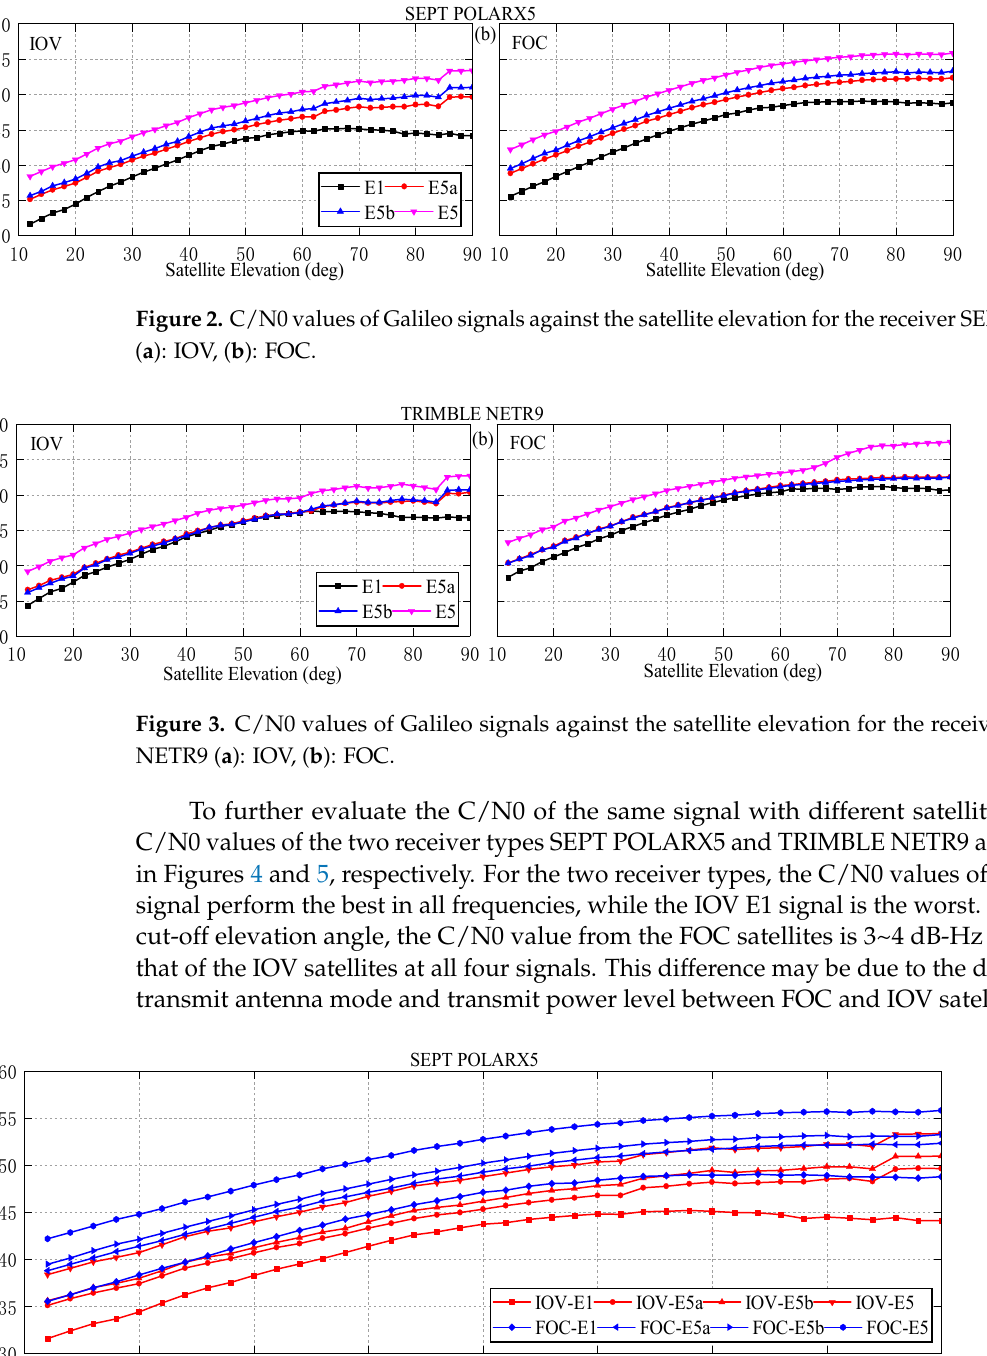
Table 2. Galileo frequencies and wavelengths.